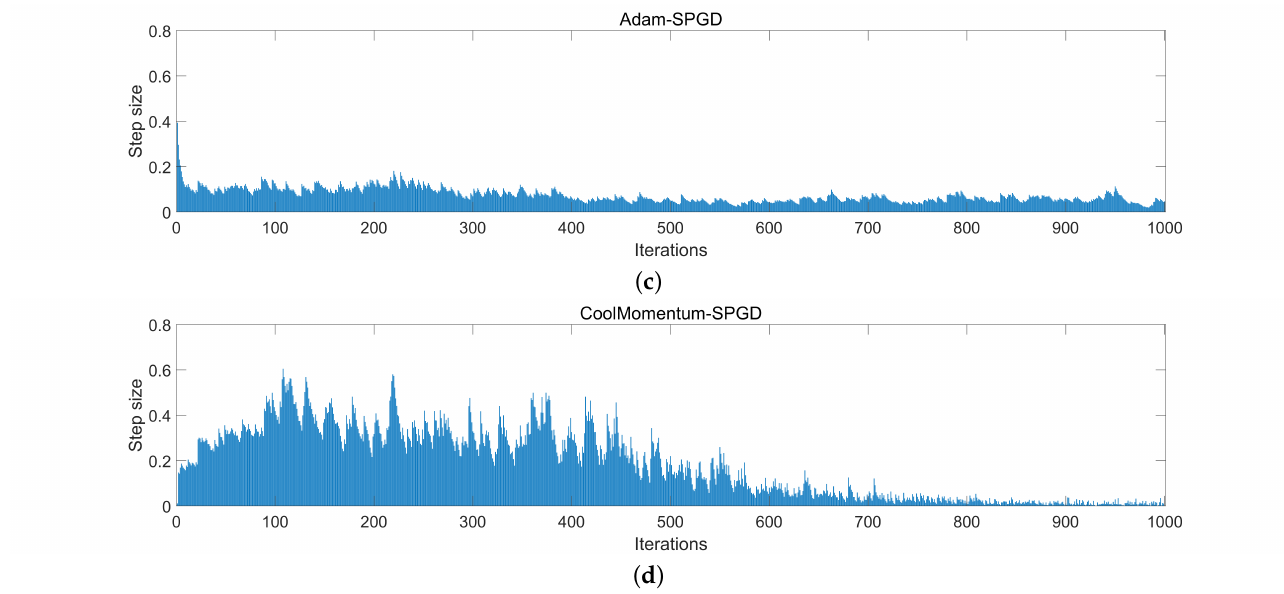
Figure 7. Step size (cid:107) ∆ u ( n + 1 ) (cid:107) for the ( n + 1 ) -th iteration during the whole iterative procedure of algorithms ( a ) SPGD, ( b ) Momentum-SPGD, ( c ) Adam-SPGD and ( d ) CoolMomentum-SPGD.